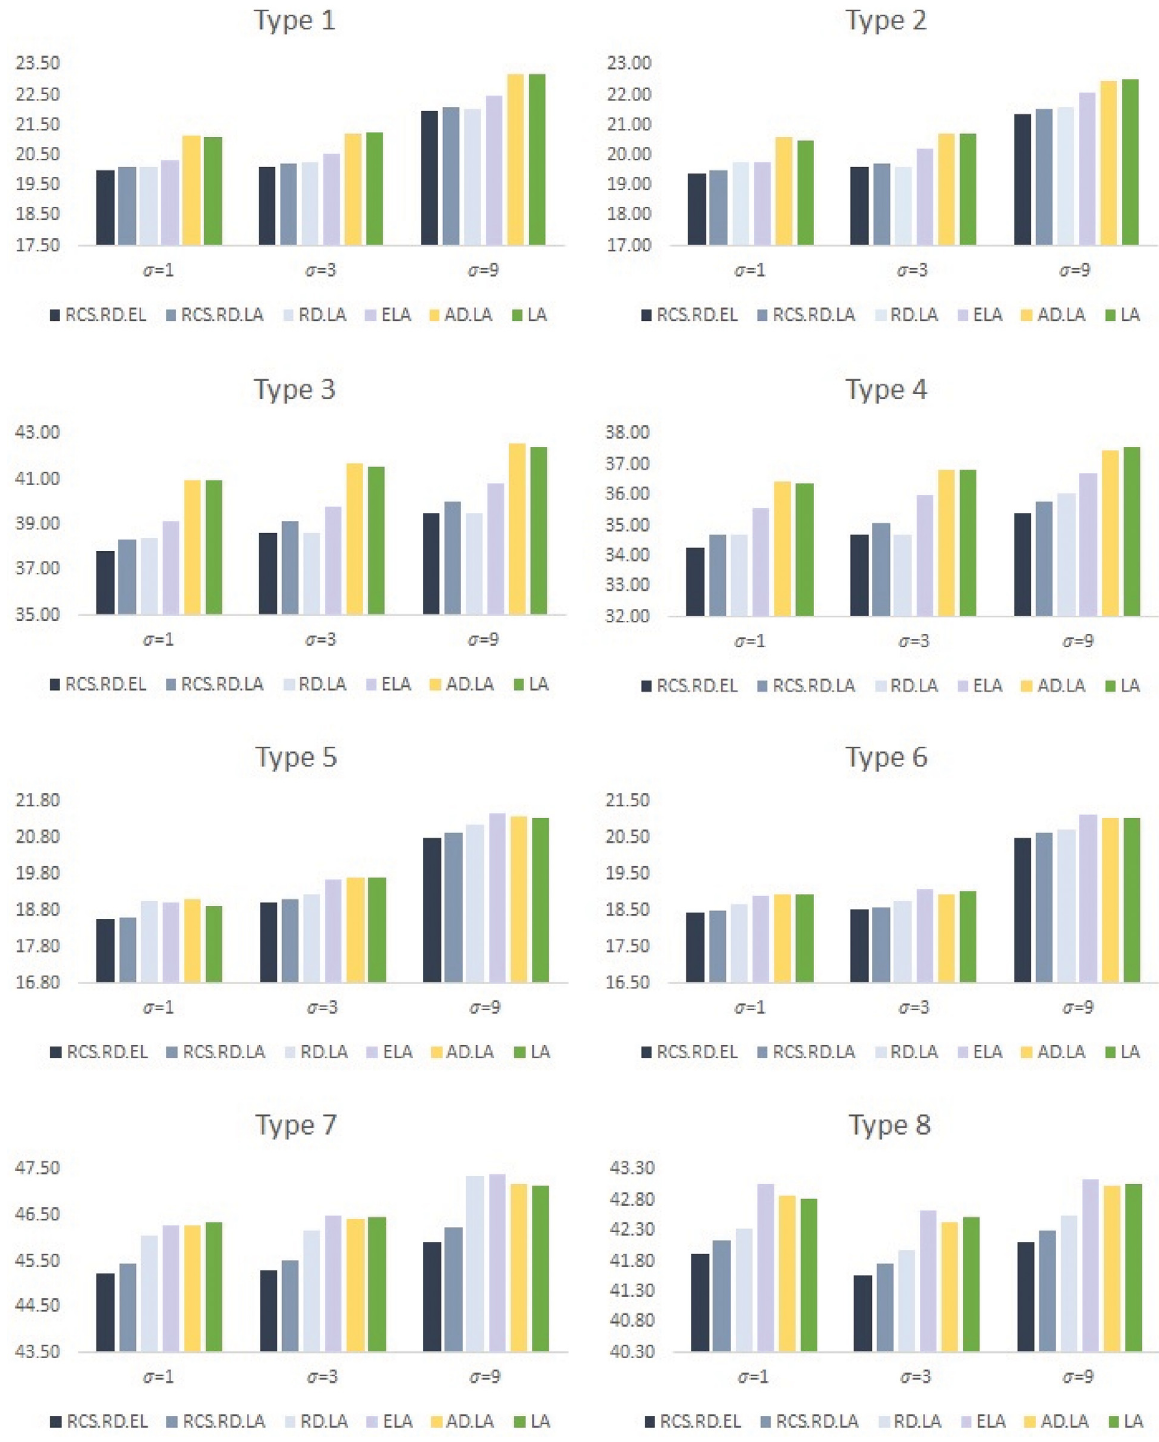
Fig 1. Prediction error: Root mean squared error.